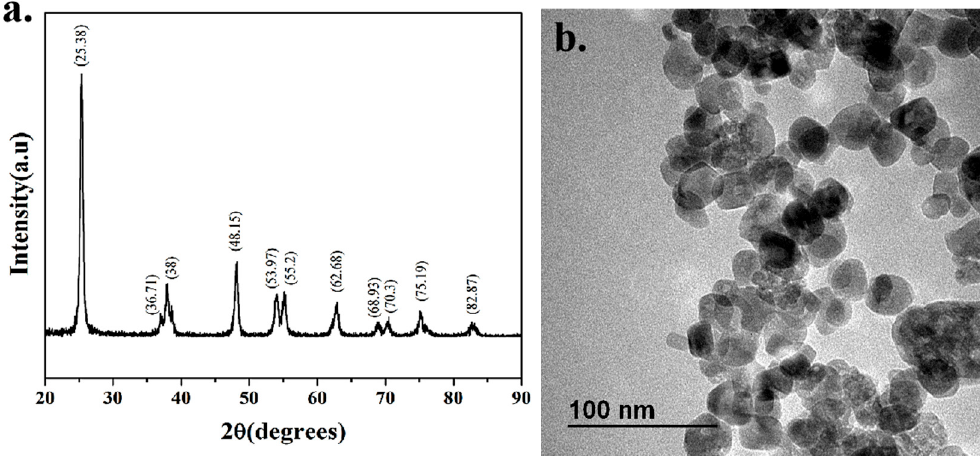
Figure 1. Characterization of nanomaterials. ( a ) XRD pattern of titanium dioxide nanoparticles (TiO 2 -NPs); ( b ) TEM image of TiO 2 -NPs.